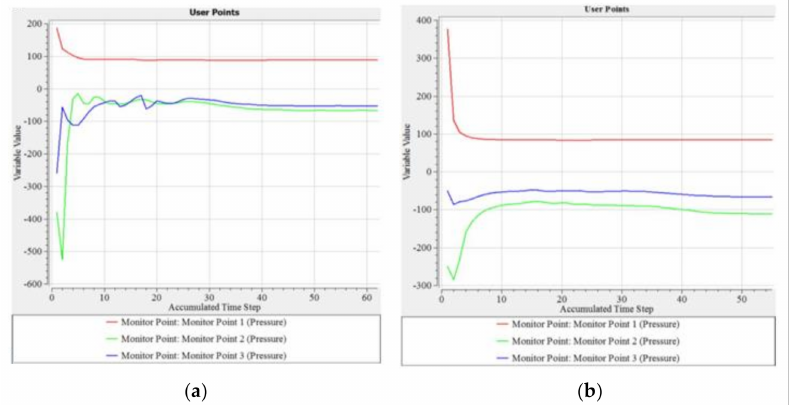
Figure 11. Changes of wind pressure in [Pa] depending on iteration: ( a ) Wind direction 1; ( b ) Wind direction 2.